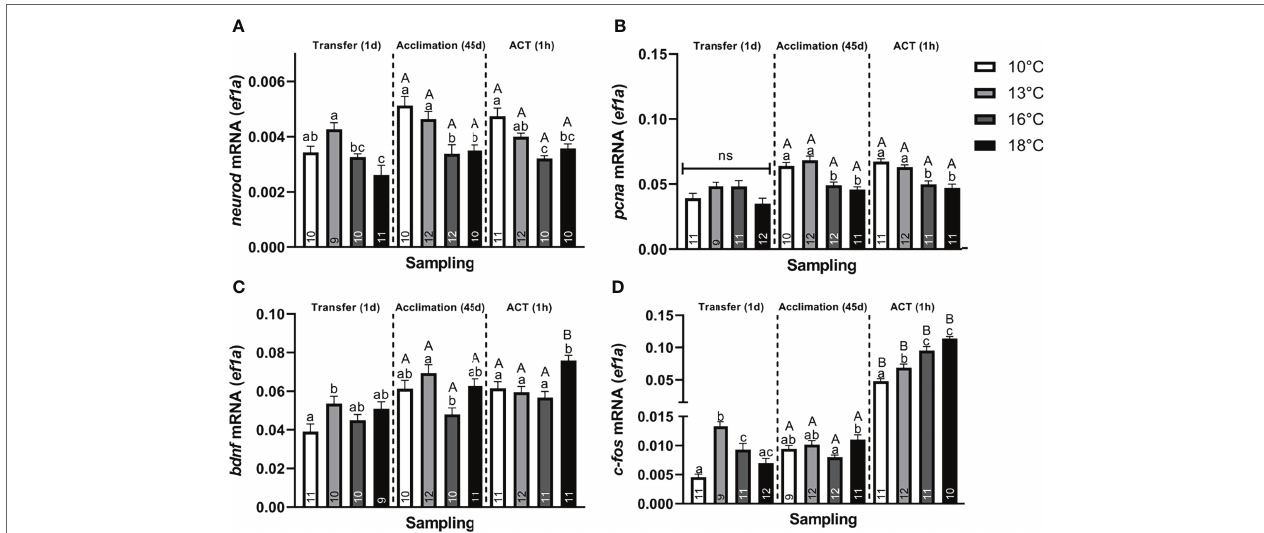
FIGURE 4 | Changes in whole telencephalic expression of (A) neural differentiation factor D ( neurod ), (B) proliferating nuclear antigen ( pcna ), (C) brain–derived neurotrophic factor ( bdnf ), and (D) c–fos in post–smolts at Transfer (1d), Acclimation (45d), and ACT (1h). Values are presented as averages ± SEM of each treatment, with sample (n) indicated within each treatment bar of the figure. Uppercase letters indicate significant difference within a treatment between the Acclimation (45d) (non–stressed) and ACT (1h) (stressed), whereas lowercase letters indicate a significant difference between temperature treatments within a sampling. A significant difference was held at P <